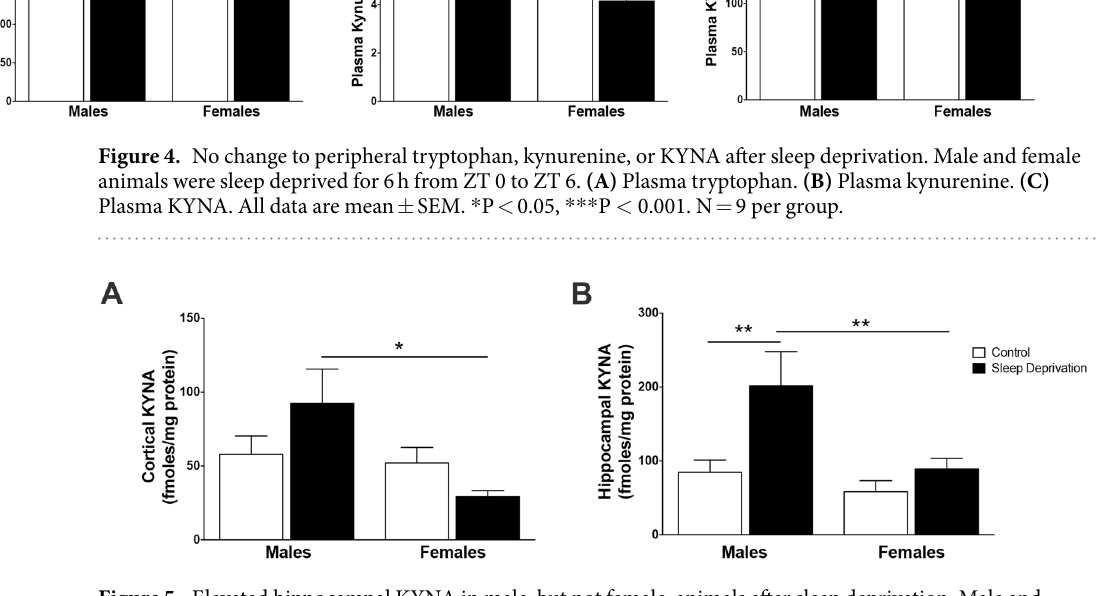
Figure 5. Elevated hippocampal KYNA in male, but not female, animals after sleep deprivation. Male and female animals were sleep deprived for 6 h from ZT 0 to ZT 6. (A) Cortical KYNA. (B) Hippocampal KYNA. All data are mean ± SEM. * P < 0.05, ** P < 0.01. N = 7 − 9 per